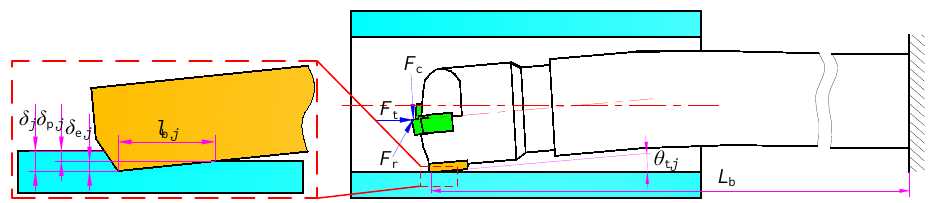
Figure 4. Extrusion deformation between the guide pads and the hole wall.